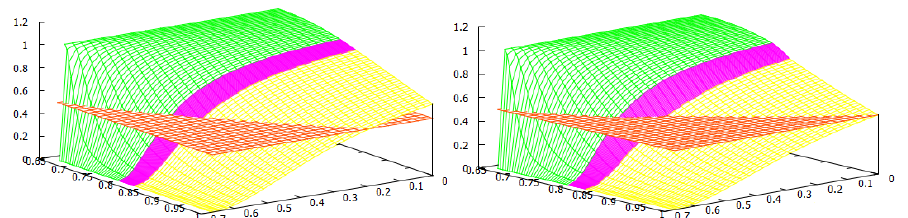
Figure 3. Left : The Nash profit share Sh π N country X j . See Equation (17).